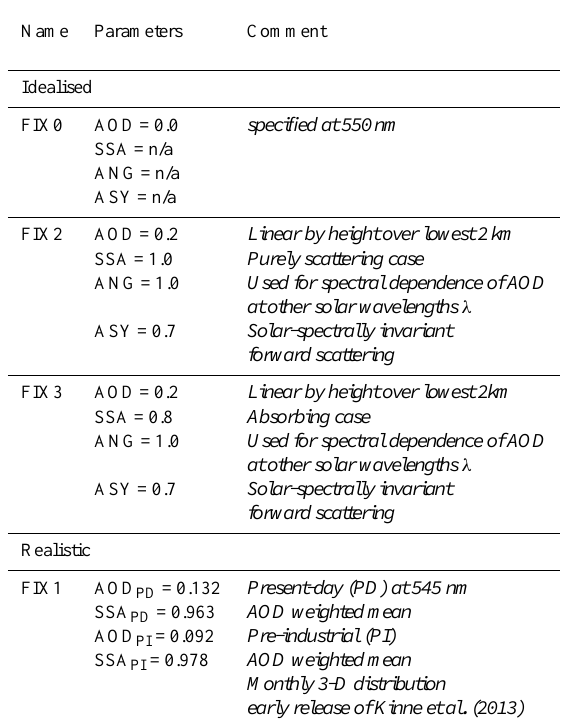
Table 1. Setup of the AeroCom Prescribed simulations. All param- eters in FIX0, FIX2, FIX3 are assumed globally and seasonally in- variant. Experiment names have historical order but are retained for